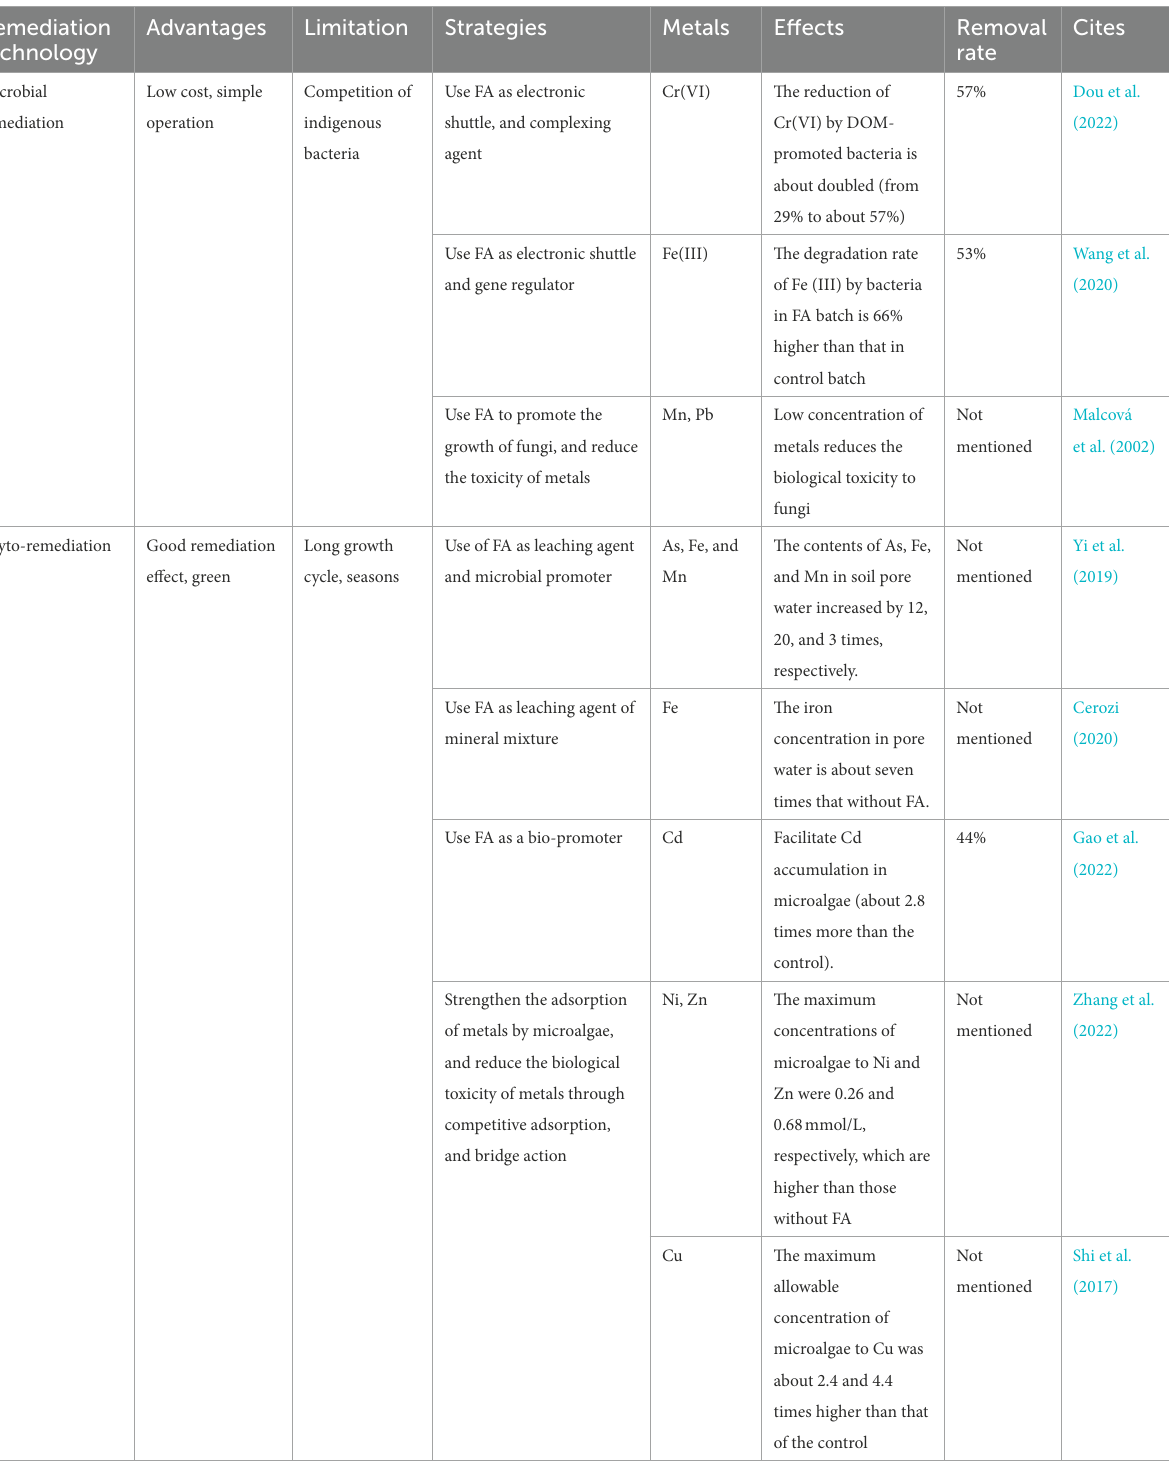
TABLE 2 Impact of FA on bioremediation for metals